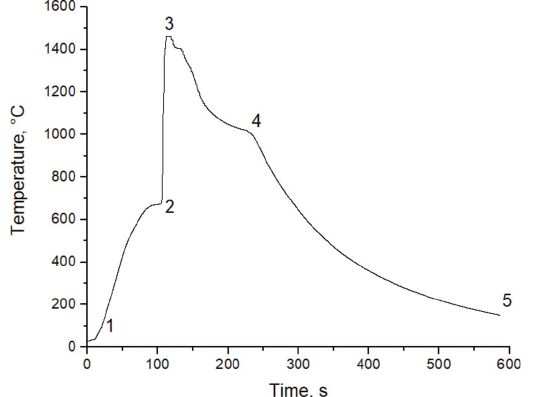
Figure 5 Thermogram of the in situ process of high-temperature synthesis of Ti (64 wt%) + Al powder mixture (MA, t = 7 min, 40 g , cladding (cid:2) = 40